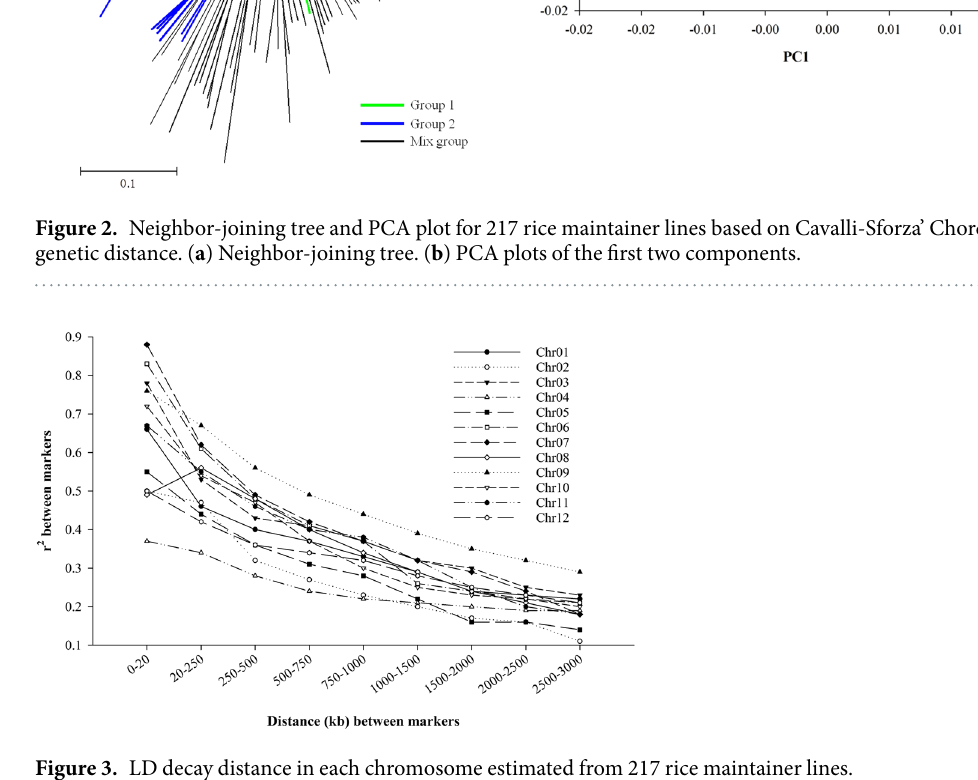
Figure 3. LD decay distance in each chromosome estimated from 217 rice maintainer